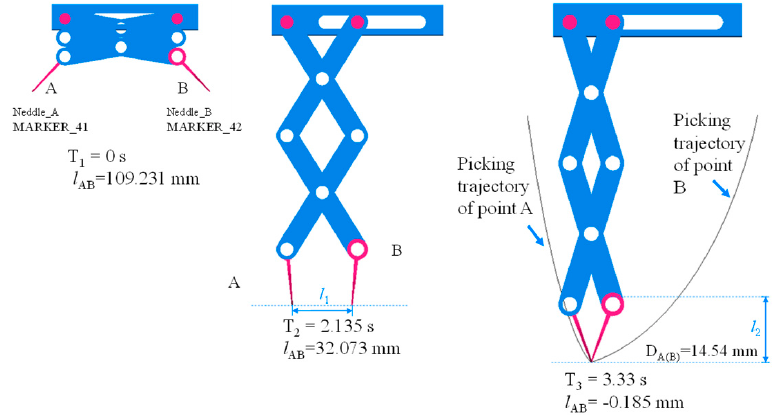
Figure 14. Trajectory diagram simulated by ADAMS.